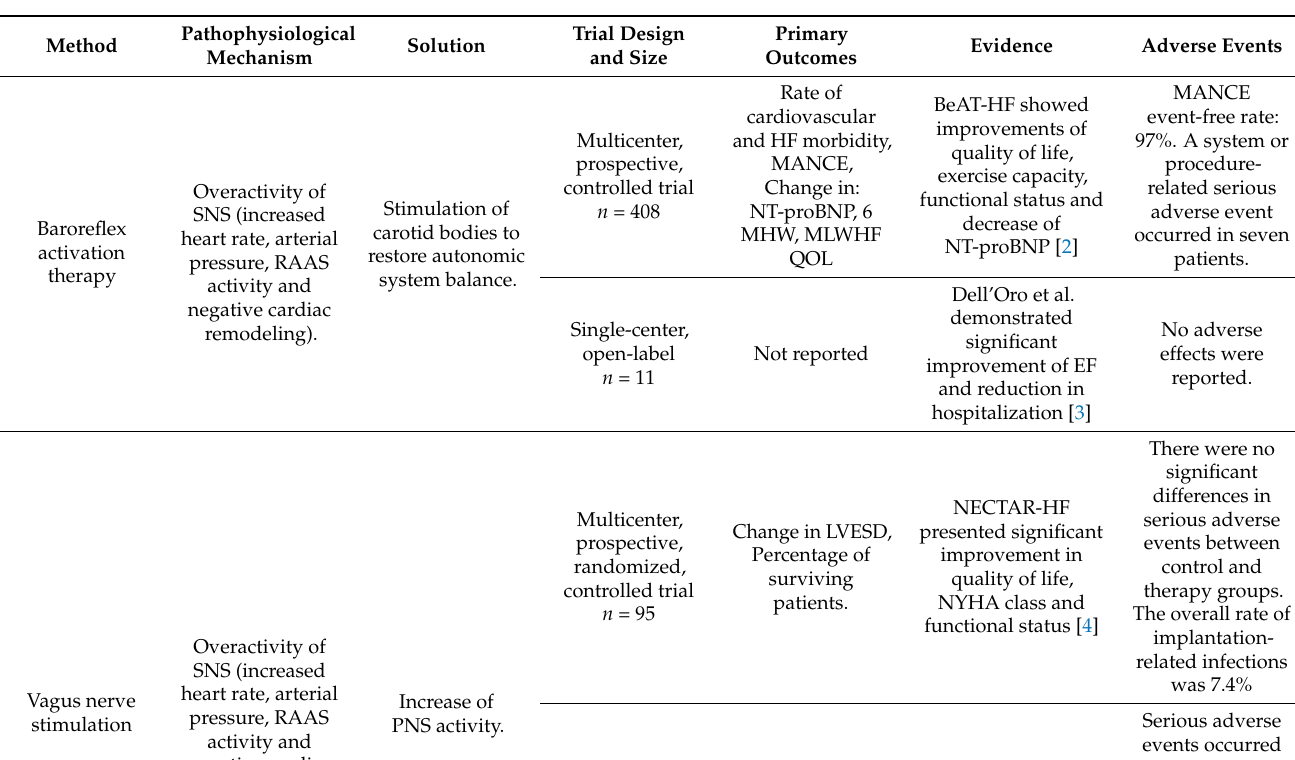
Table 1. Summary of the proposed novel